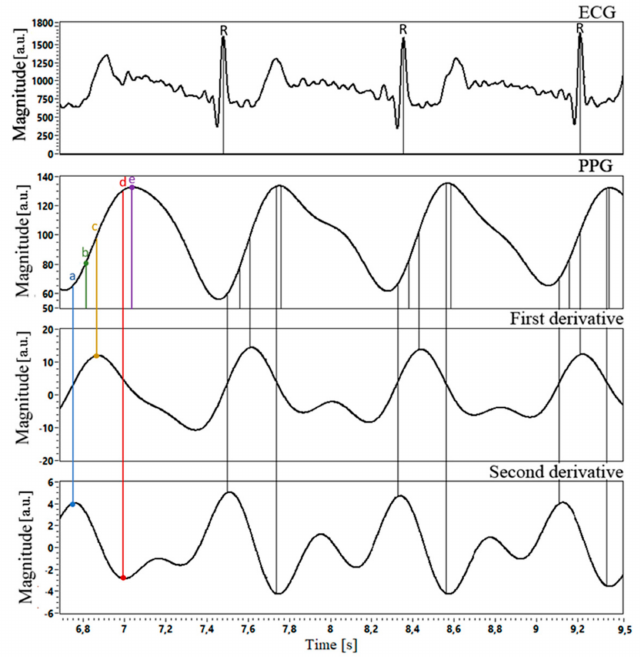
Figure 5. Example of the ECG and respective PPG waveforms with 1st and 2nd PPG derivatives. The characteristic points (a-e) are indicated on the PPG waveform: ( a ) intersecting tangents (IT) ( b ) maximum 2nd derivative (APGmax) ( c ) maximum 1st derivative (VPGmax) ( d ) minimum 2nd derivative (APGmin) ( e ) PPG maximum value (PPGmax).